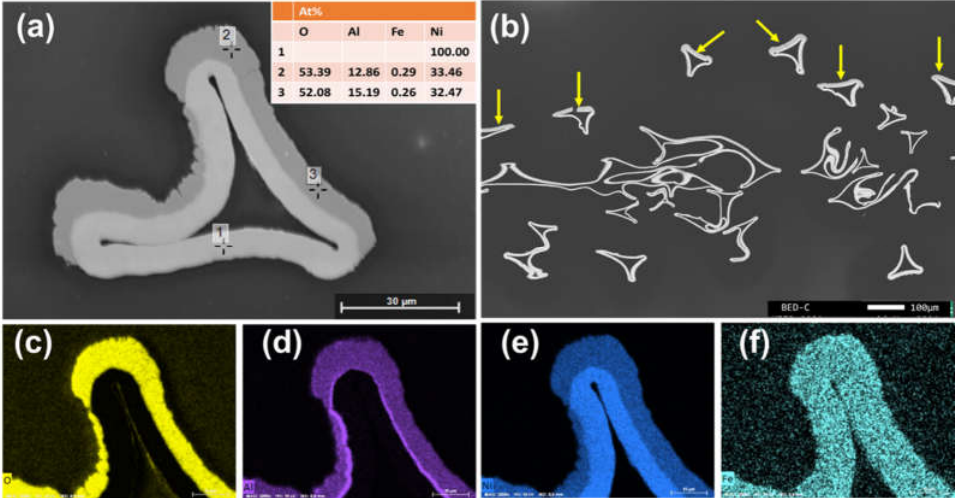
Figure 4. Cross-sectional SEM images of Raney-Ni electrode in the as-leached state ( a , b ) and elemental mapping images for ( c ) oxygen, ( d ) aluminum, ( e ) nickel, and ( f ) iron.